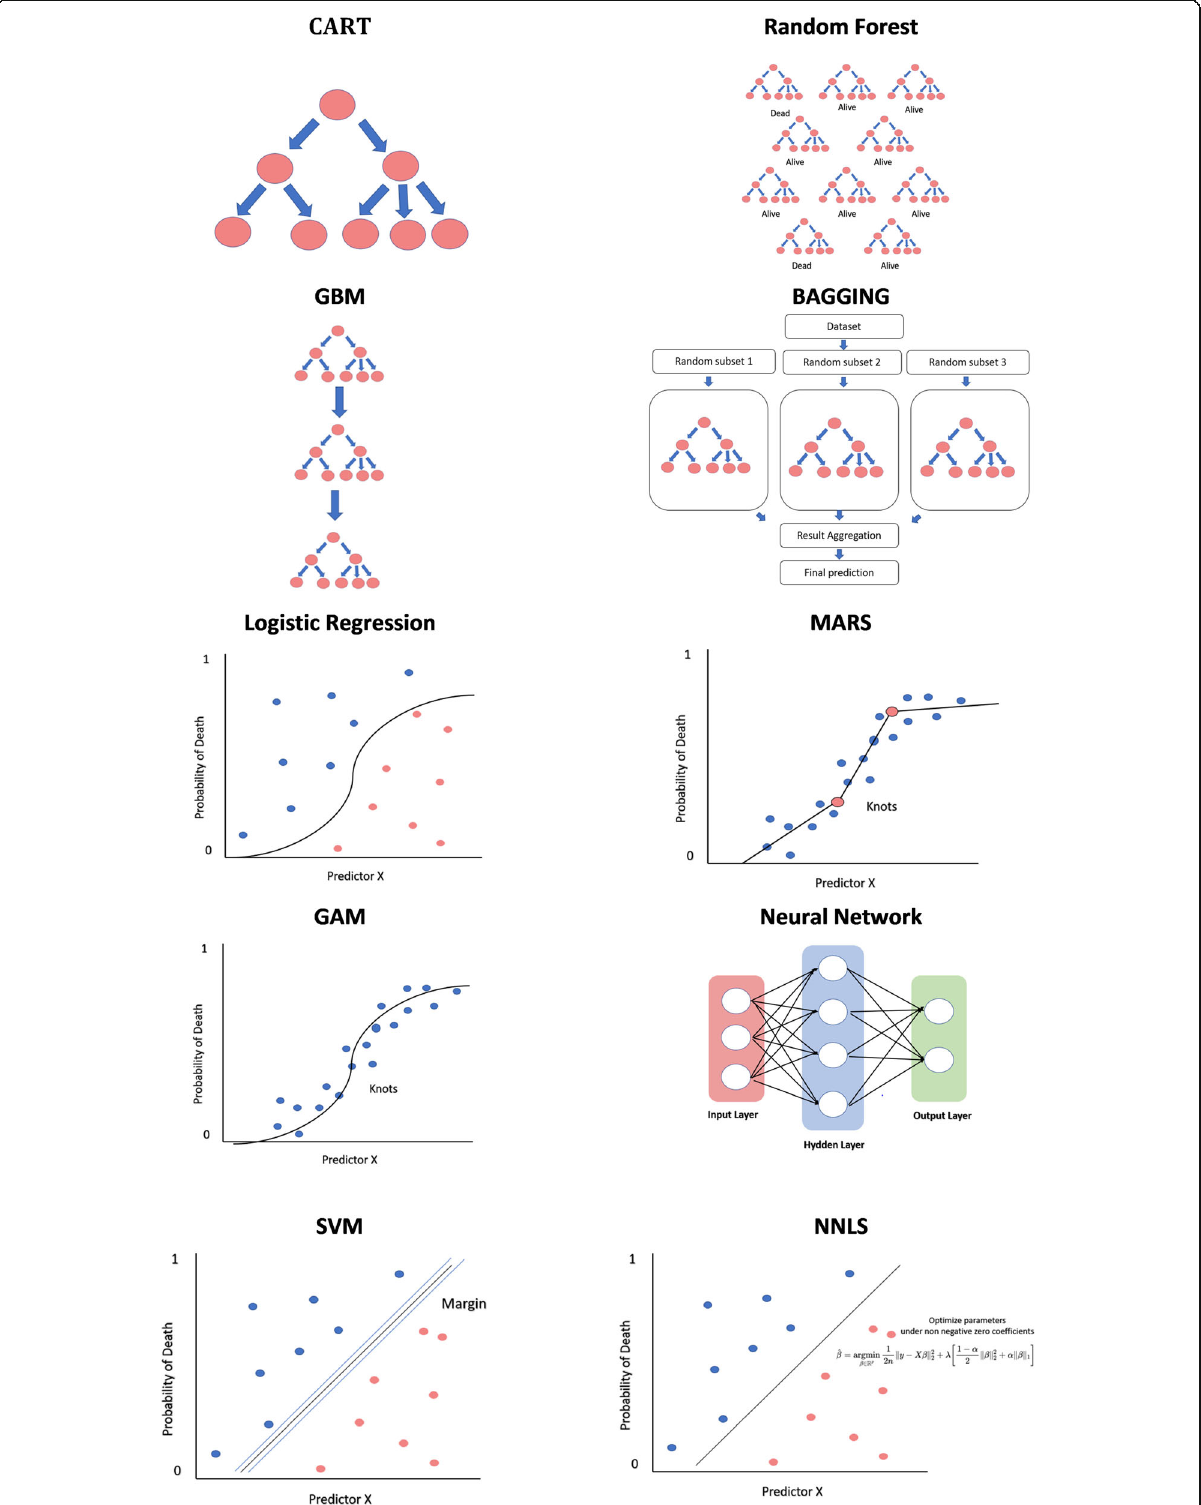
Fig. 1 Schematic representation of the base learners used in the Super Learner ensemble